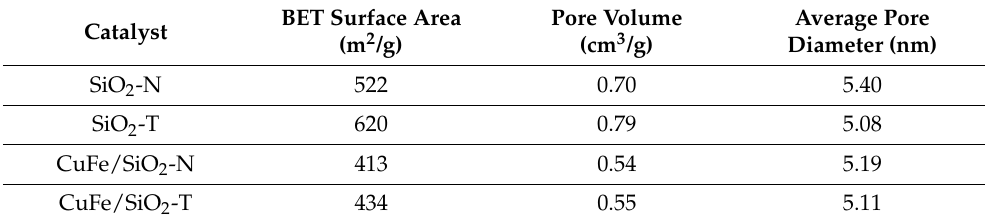
Table 1. Detailed physicochemical properties of the calcined